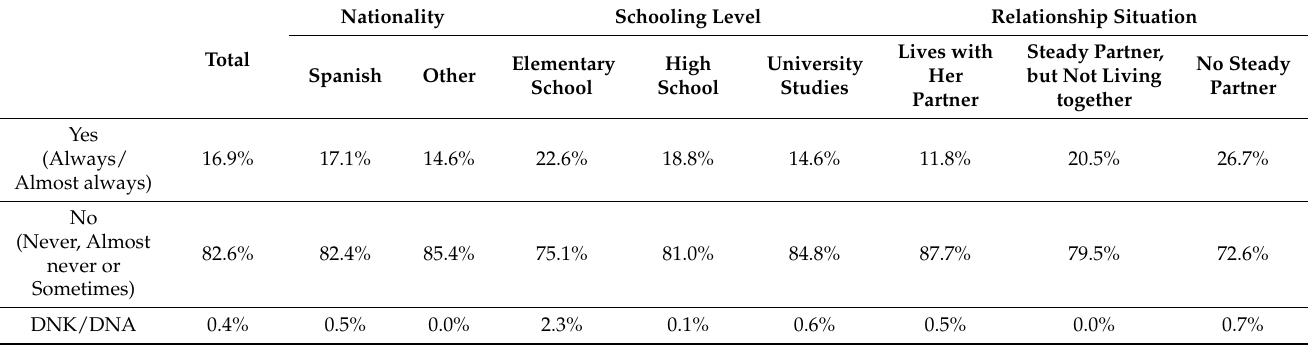
Table 6. Use of the dual method according to nationality, having a partner or not and schooling